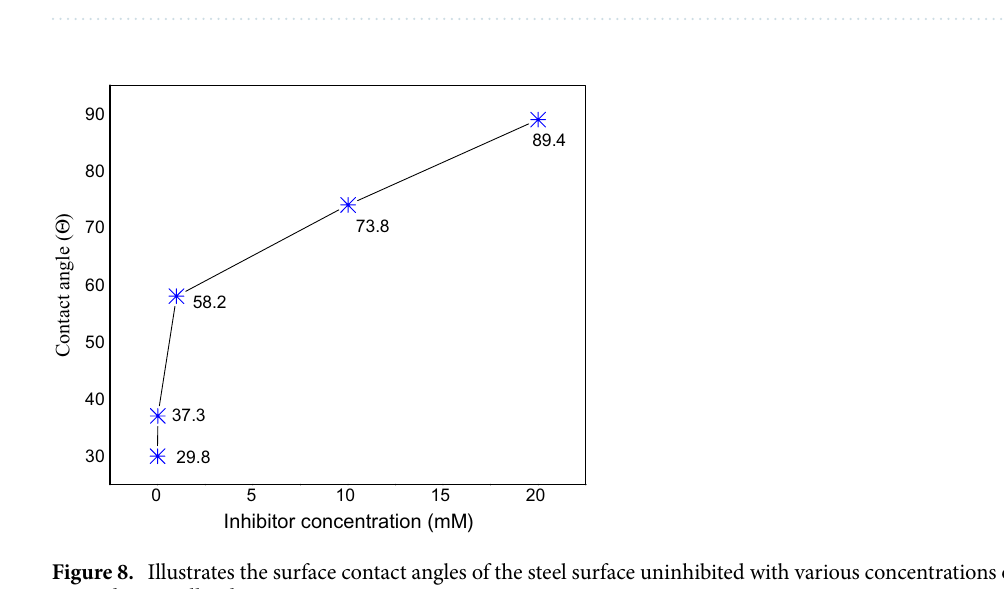
Table 6. Comparative data showing the performance of the other drugs.